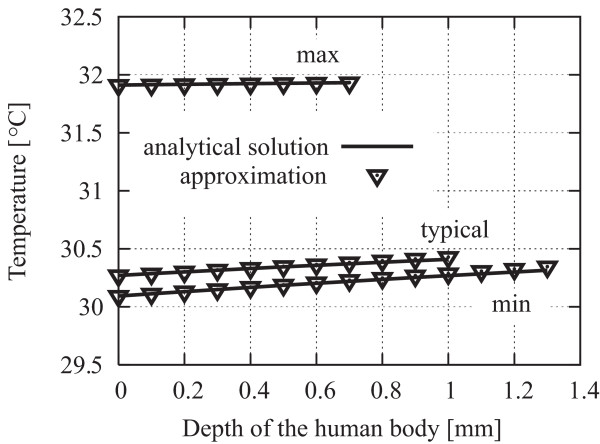
Temperature distributions in the skin tissue before exposure. Comparison between the results obtained from the analytical exact solution (2) and the derived approximate expression (12).